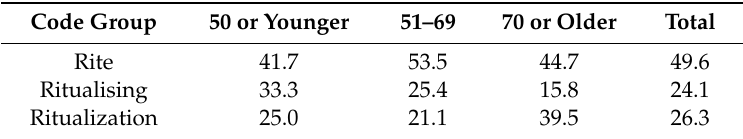
Table 5. Dimensions of prayer—personal context—age. Code Group